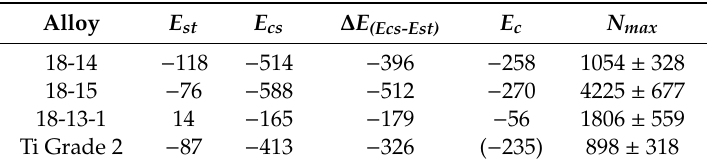
Table 7. Electrochemical parameters and functional fatigue life ( N max ) of the 18-14, 18-15, and 18-13-1 alloys and Ti Grade 2 obtained during mechanocycling in Hanks’ solution.